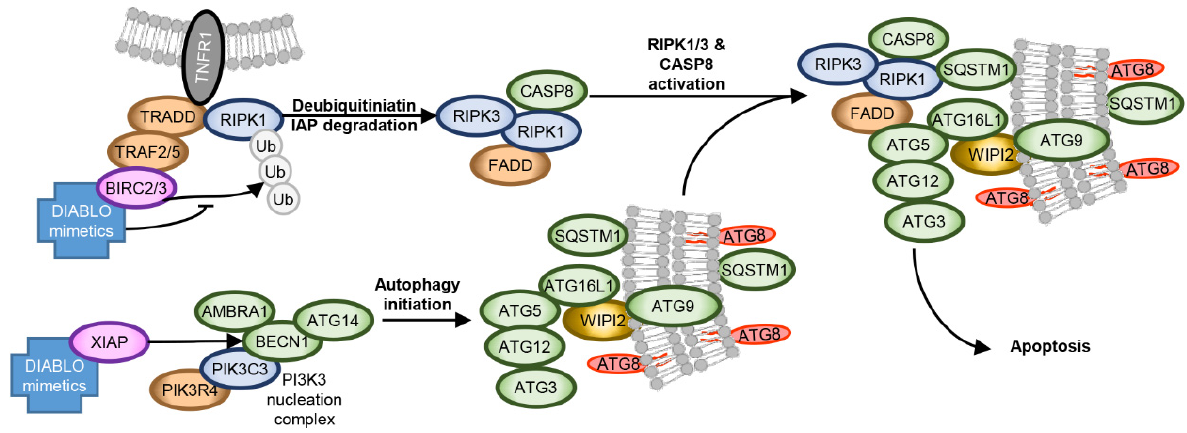
Figure 3. DIABO/SMAC mimetic mediated apoptosis. Treatment of latent HIV-infected cells with DIABLO/SMAC mimetics induces the degradation of XIAP and BIRC2/3, inducing autophagy, the deubiquitination of RIPK1, and the disinhibition of caspases. This leads to the formation of a death inducing signalling complex comprising of FADD, RIPK1, RIPK3 and caspase-8 on autophagosomal membranes, resulting in the cleavage and activation of caspase-8, thus enabling activation of the effector caspases (caspase-3 and caspase-7) and the execution of apoptosis.